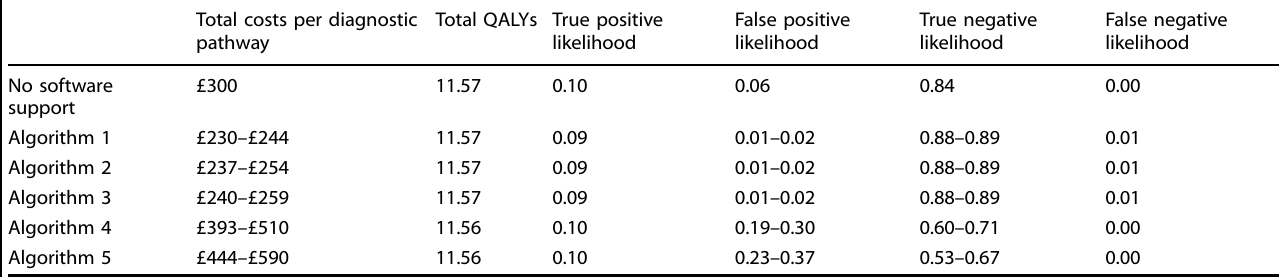
Table 6. Summary of results from the variants in Fig. 11 comparing the calculated total costs per patient pathway and QALYs to the algorithm accuracy.